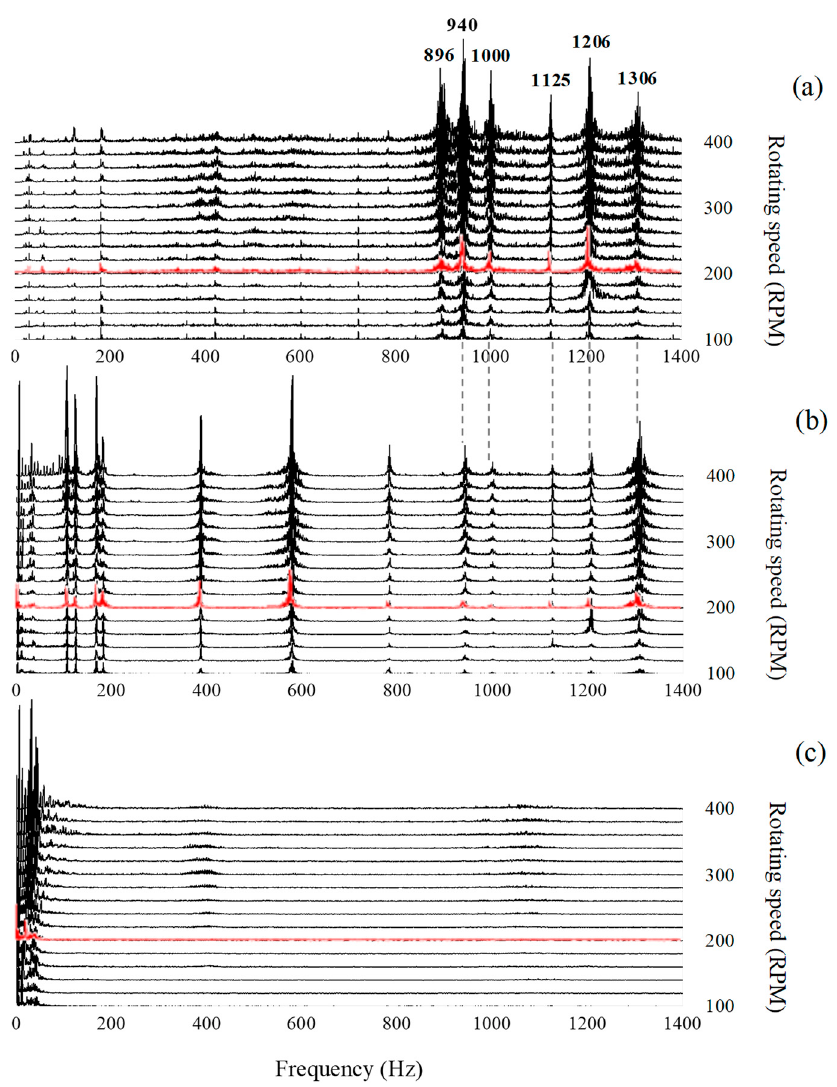
Figure 5. Waterfall plot of the noise and vibration for various rotating speeds of the assembled wheel bearing: ( a ) noise, ( b ) vibration of the dust shield, and ( c ) vibration of the outer ring.